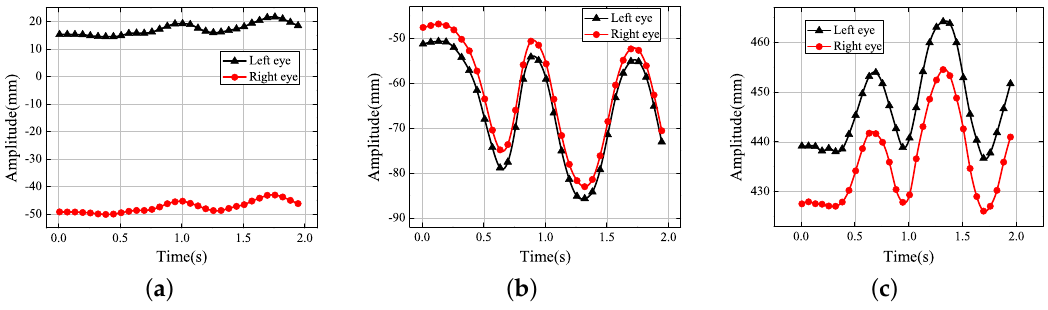
Figure 15. Experimental results obtained during driving over speed bumps: ( a ) X axis; ( b ) Y axis; ( c ) Z axis.